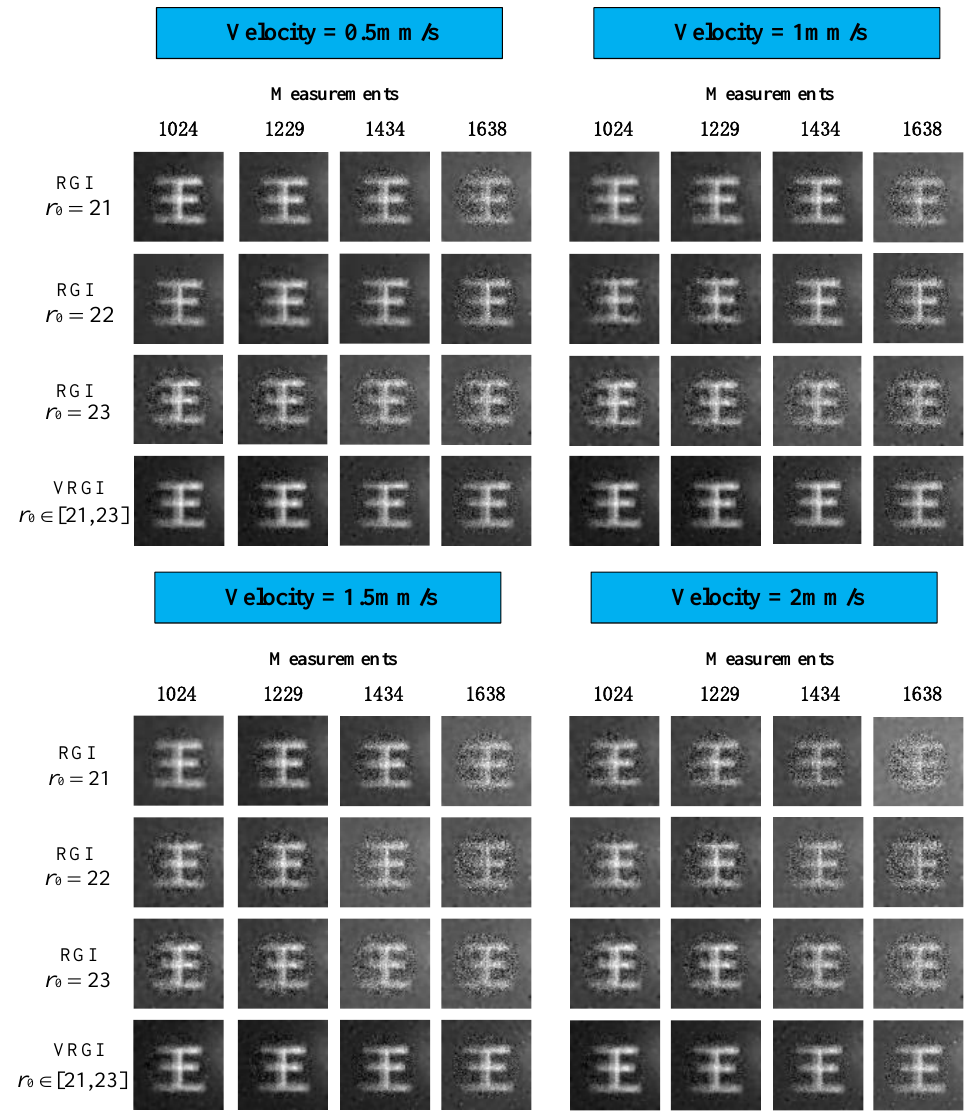
Figure 2. Reconstruction of an axially moving target by RGI and VRGI with different measurements and differen t velocities.